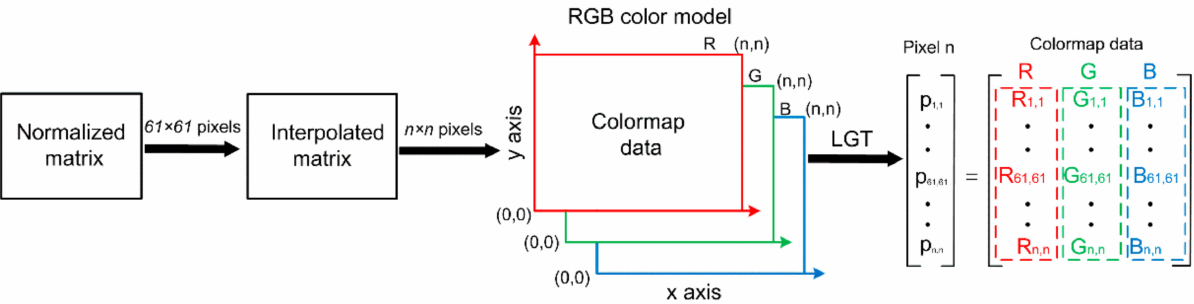
Figure 11. The data-processing procedure for transforming the acquired experimental signal peaks to RGB image